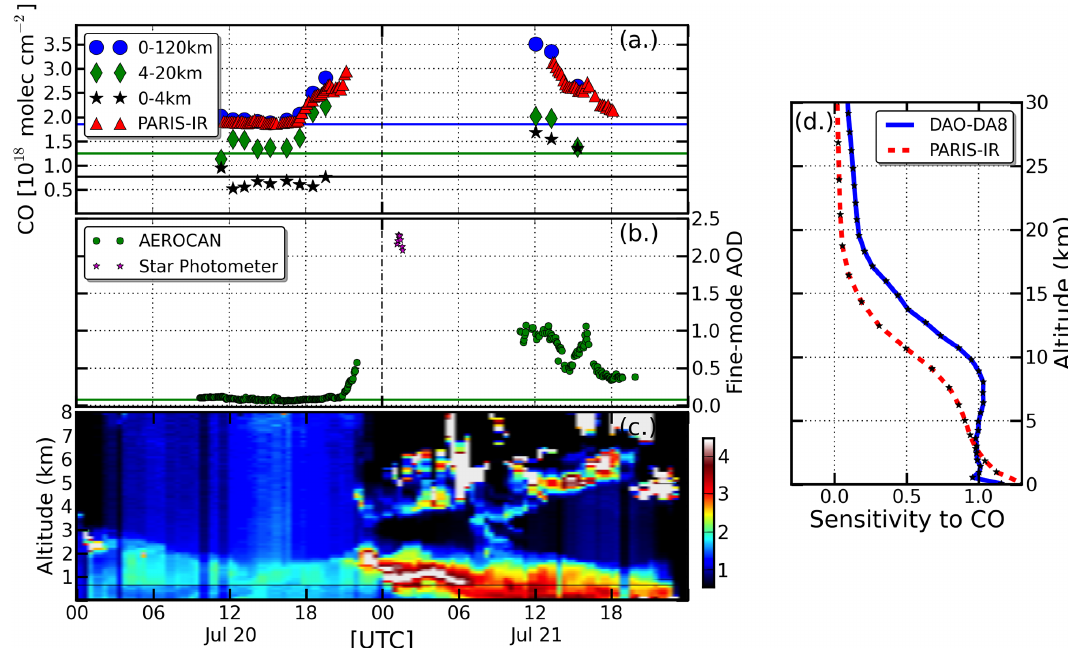
Figure 3. DGS observations of the 20–21 July biomass burning event. (a) Retrieved total and partial columns of CO (in molec cm − 2 ). Horizontal lines represent typical background total and partial columns of CO at DGS (0–4km lowest, 4–20km middle, total column upper). (b) Fine-mode AOD as measured by the sun and star photometers. The horizontal line represents the typical background fine-mode AOD at DGS. (c) DRL attenuated backscatter ratio showing vertical distribution of aerosols above DGS. (d) Sensitivity, as a function of altitude, of the PARIS-IR and DAO-DA8 retrievals of CO to the true profile rather than the a priori